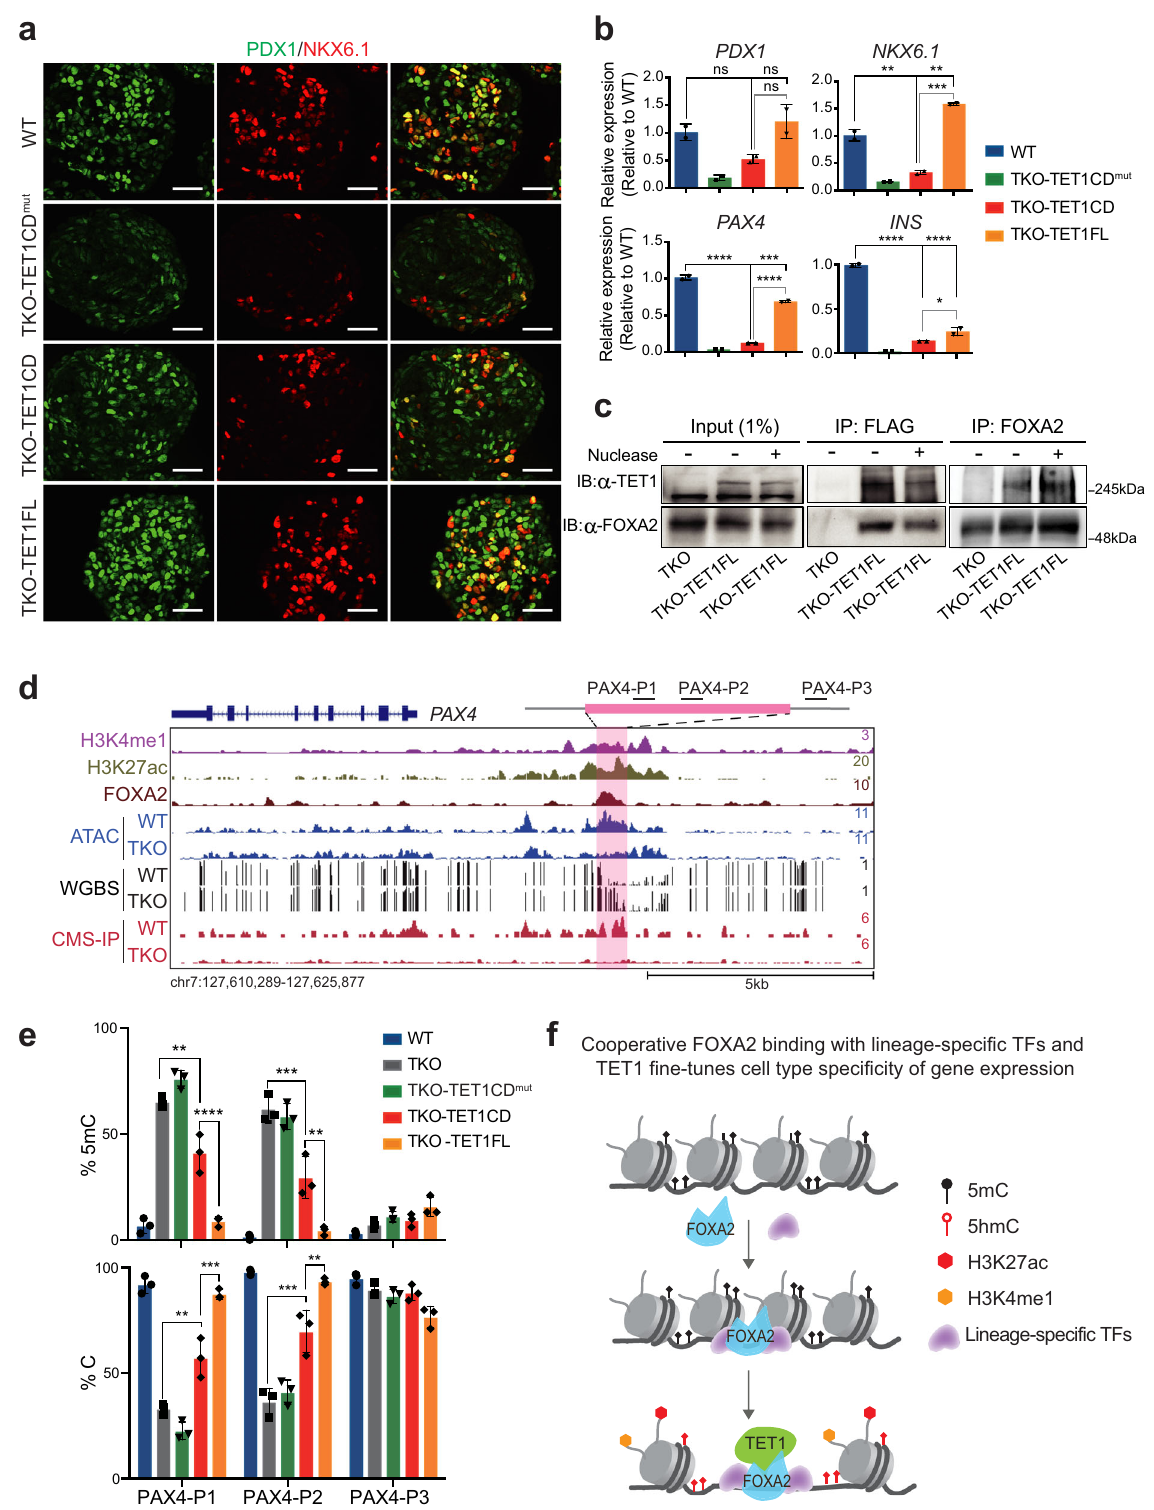
remained unchanged for TET2/3DKO (Supplementary Fig. 6d, left panel). A corresponding decrease in unmethylated cytosine content was observed, with values of 45-65% and ~35% of C in TET1KO and TKO samples, respectively (Supplementary Fig. 6d, right panel). As a housekeeping control, we examined methyla- tion content at a nearby region using the PAX4-P3 primer, and as expected, no signi fi cant differences in 5mC and C were observed